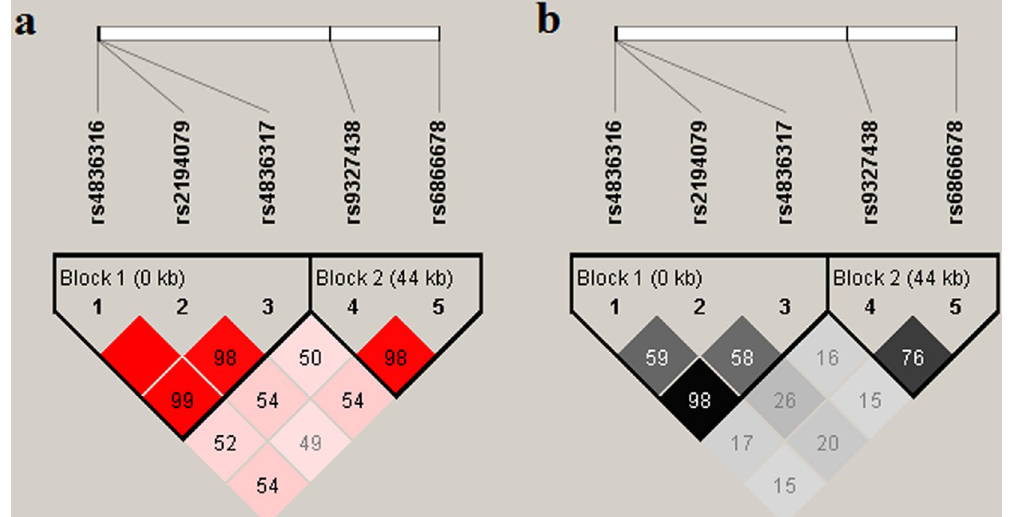
Figure 1. Linkage disequilibrium (LD) block constructed from 5 SNPs in MEGF10 . ( a ) Markers with linkage disequilibrium (LD) ( D ’ < 1 and LOD > 2) are shown in red through pink (color intensity decreases with decreasing D ’ value). D ’ value shown in each square represents pairwise LD relationship between the two polymorphisms. D prime values of 1.0 are never shown (the box is empty). The LD plot was generated using the Haploview program. ( b ) The value of r 2 is shown in each square. Black square indicated r 2 = 1 (i.e. perfect LD between a pair of SNPs). Markers with LD are shown in black to grey (color intensity decreases with decreasing r 2